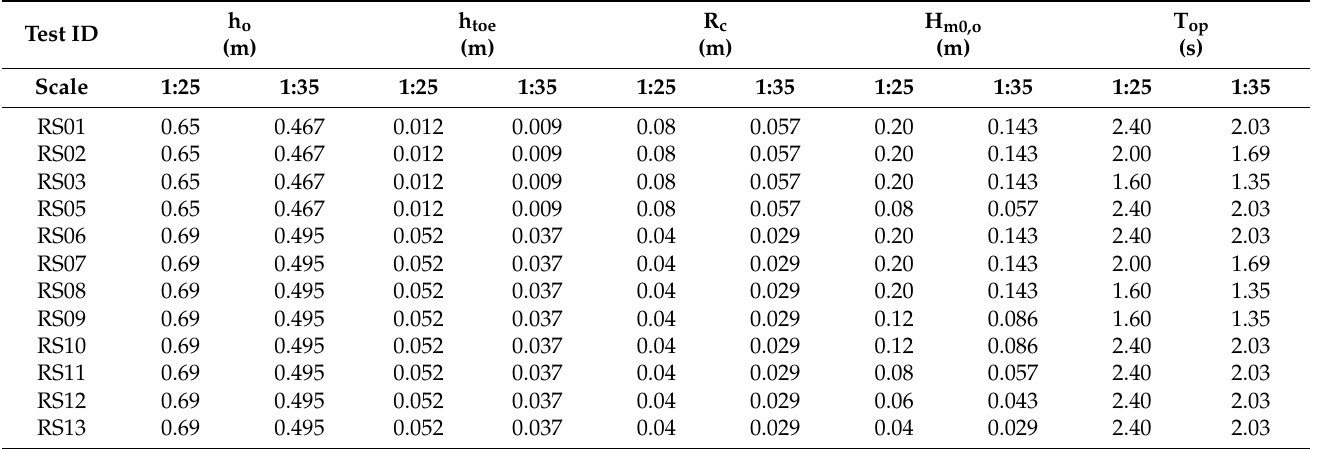
Table 1. Test matrix of the UGent dataset with the target hydrodynamic conditions, with 2nd-order generated irregular waves.